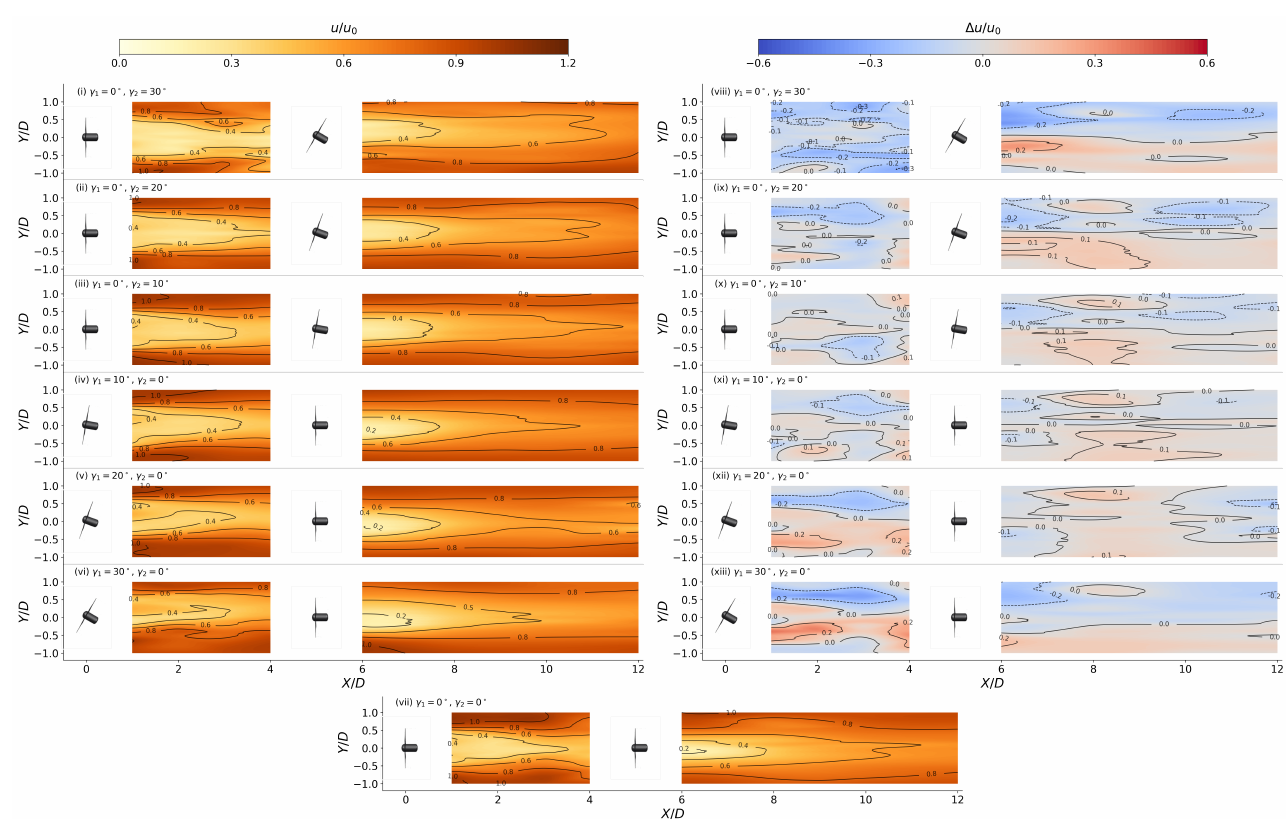
Figure 8. Normalised turbine wake velocity distributions for the cases of Scenario 2 and relative differences in normalised velocity between yawed and non-yawed turbine configurations: (i) u / u 0 = u 0 ◦ ,10 ◦ / u 0 , (ii) u / u 0 = u 0 ◦ ,20 ◦ / u 0 , (iii) u / u 0 = u 0 ◦ ,30 ◦ / u 0 , (iv) u / u 0 = u 10 ◦ ,0 ◦ / u 0 , (v) u / u 0 = u 20 ◦ ,0 ◦ / u 0 , (vi) u / u 0 = u 30 ◦ ,0 ◦ / u 0 , (vii) u / u 0 = u 0 ◦ ,0 ◦ / u 0 , (viii) ∆ u / u 0 = ( u 0 ◦ ,10 ◦ − u 0 ◦ ,0 ◦ ) / u 0 , (ix) ∆ u / u ∆ u / u ∆ u / u = ( u − u ) / u = ( u − u ) / u = ( u − u ) / u 0 0 ◦ ,20 ◦ 0 ◦ ,0 ◦ 0 , (x) 0 0 ◦ ,30 ◦ 0 ◦ ,0 ◦ 0 , (xi) 0 0 ◦ ,0 ◦ 0 , 10 ◦ ,0 ◦ (xii) ∆ u / u 0 = ( u 20 ◦ ,0 ◦ − u 0 ◦ ,0 ◦ ) / u 0 , and (xiii) ∆ u / u 0 = ( u 30 ◦ ,0 ◦ − u 0 ◦ ,0 ◦ ) / u 0 . The quoted distances are downstream of the upstream turbine in all